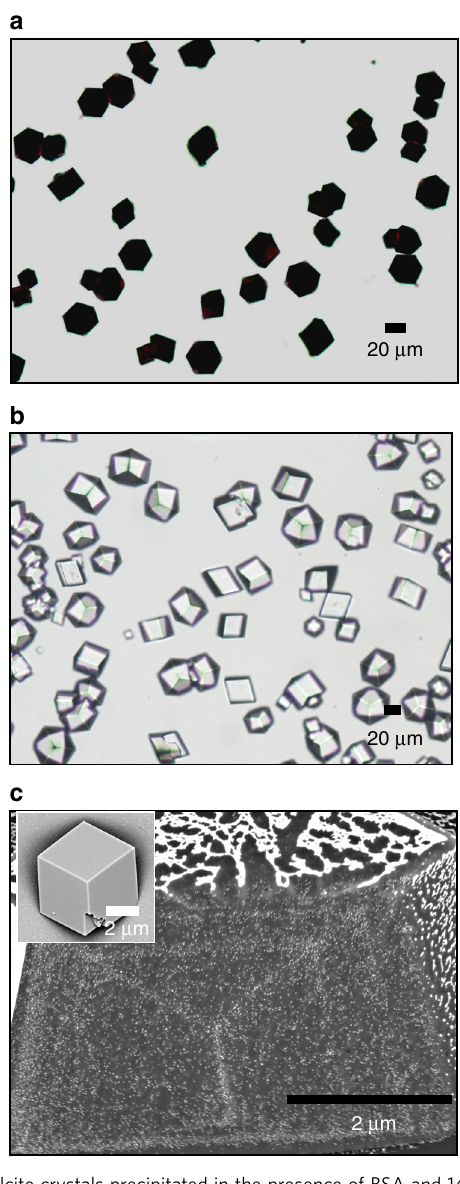
Fig. 3 Calcite crystals precipitated in the presence of BSA and 14 nm BSA- NPs. a , b Optical micrographs of crystals precipitated at [Ca 2 + ] = 20 mM in the presence of a 0.05 wt% BSA-functionalised 14 nm NPs and b 0.1 wt% of BSA only. c SEM images of an FIB cross-section of calcite crystals containing